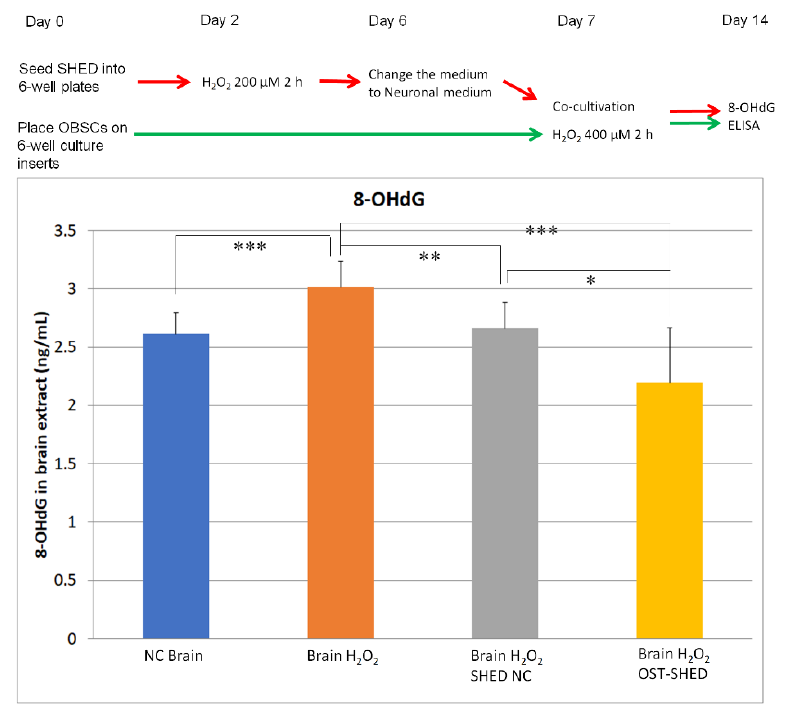
Figure 5. Cellular oxidative stress in OBSCs. At the end of cultivation (day 14), OBSCs were homogenized in RIPA buffer with ultrasound on ice. The tissue lysis was diluted and followed by 8-OHdG ELISA. Data are presented as mean ± SD. * p < 0.05, ** p < 0.01, *** p < 0.001.